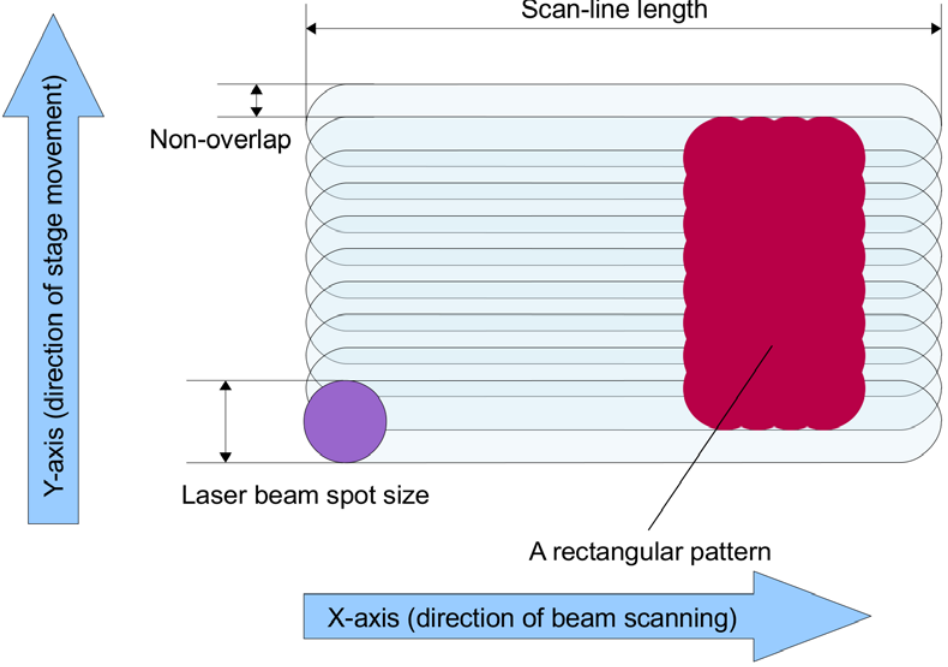
Figure 2. A schematic illustration of the concepts of scan line, non-overlap and spot size. A patterned rectangle is shown with wavy edges. The waviness in the Y -direction is caused by finite non-overlap, whereas the waviness in the X -direction is caused by the pulsed nature of the laser beam. The exact pulse duration is not known but it is assumed to be very short, so the spot produced is not smeared into an ellipse. In this image, the non-overlap is